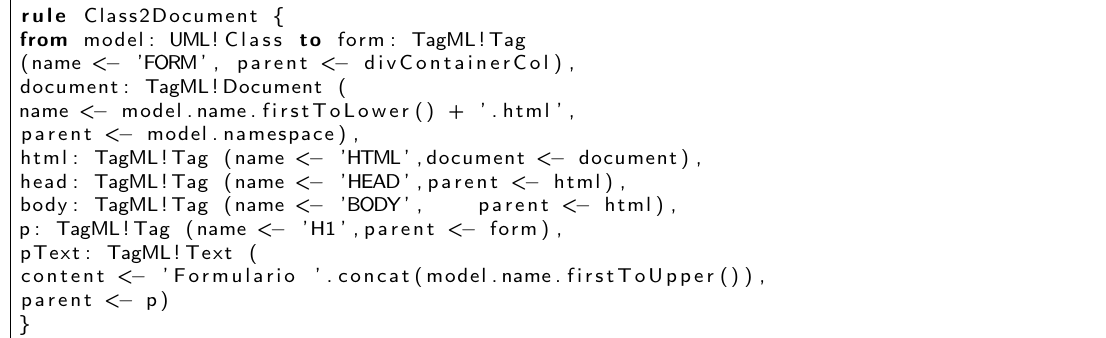
Figure 16. Rule of transformation of Class a Document in ATL.